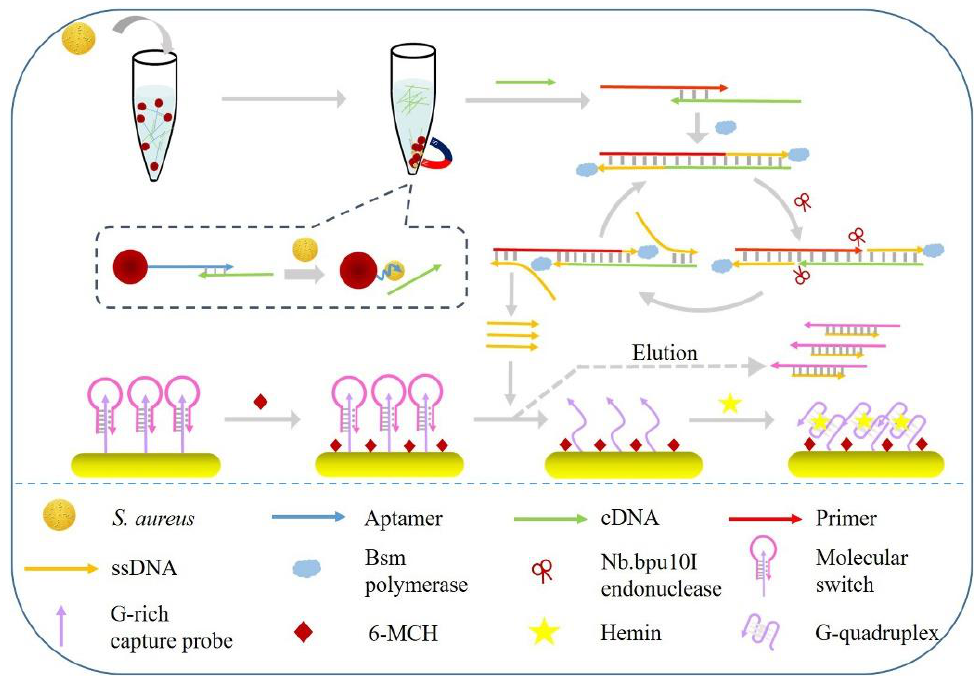
Figure 6. Schematic representation of the electrochemical detection of Staphylococcus aureus. The surface of the gold electrode is functionalized with G-rich capture probe, while the hairpin structure of the molecular switch is attached to the capture probe. The hairpin sequence stem forms a triple- stranded DNA structure with the capture probe, blocking the capture probe against G-quadruplex formation. Amplified sDNA incubated with the electrode is complementary to the ring region of the hairpin structure, so that the G-rich capture probe is exposed to the solution to form G-quadruplex, which subsequently combines with hemin to form the electroactive complex G-quadruplex/hemin. The detectable electrochemical signal is produced by the reversible redox reaction of Fe (III)/Fe (II) in hemin. Reprinted with permission from [48] Copyright (2022) Elsevier.